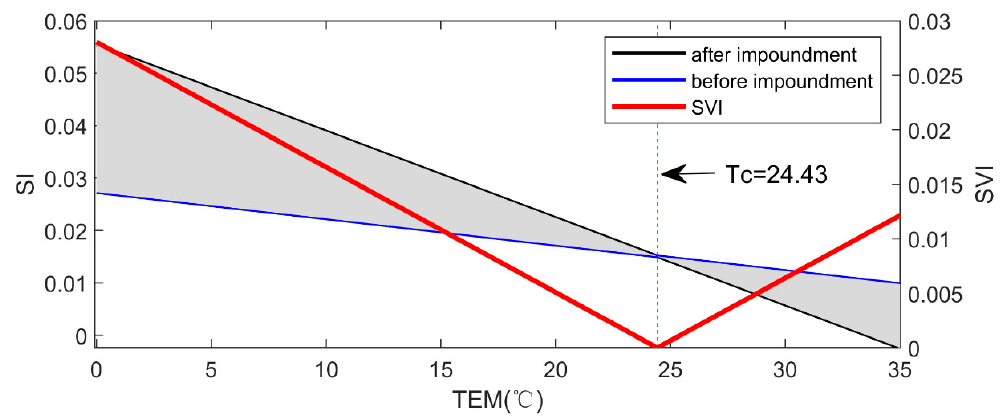
Figure 12. The sensitivity index (SI) and sensitivity variation index (SVI) for the NDVI–temperature response in 0–10 km zone (PRE = 300 mm). Table 5. SI of NDVI–temperature and temperature thresholds.